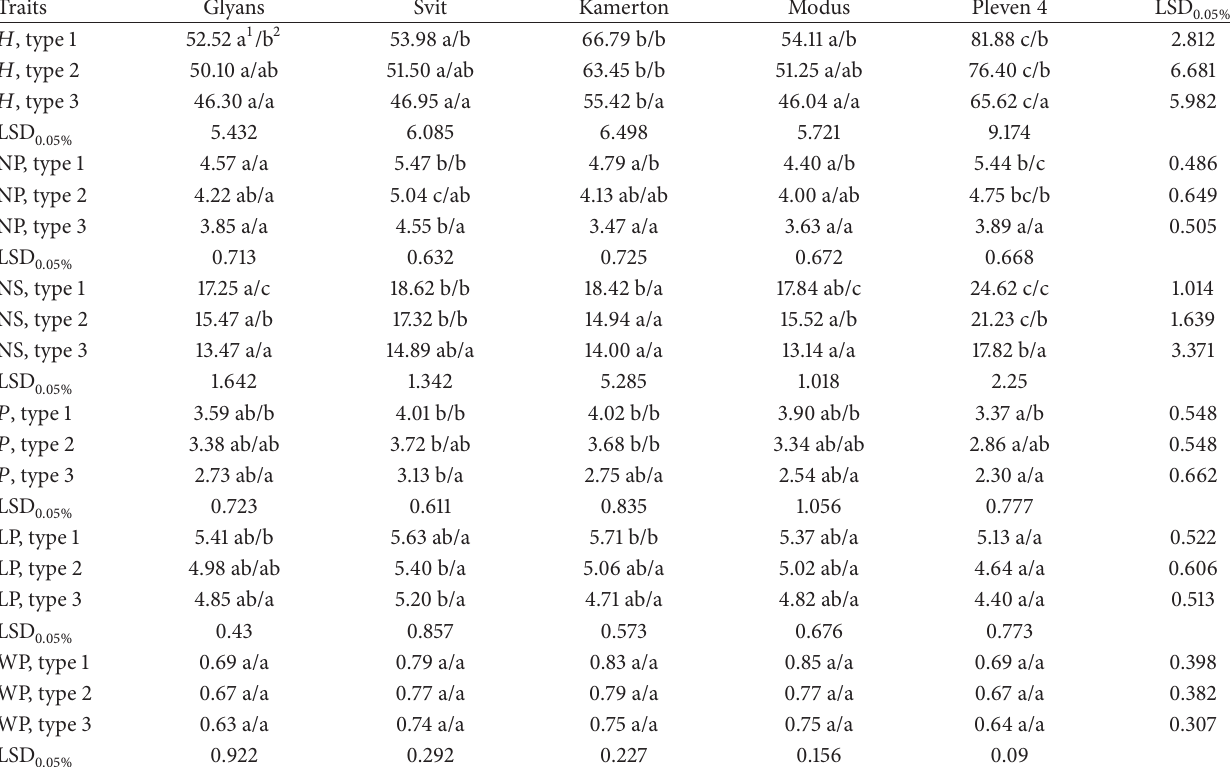
Table 5: Productivity and its basic elements in pea